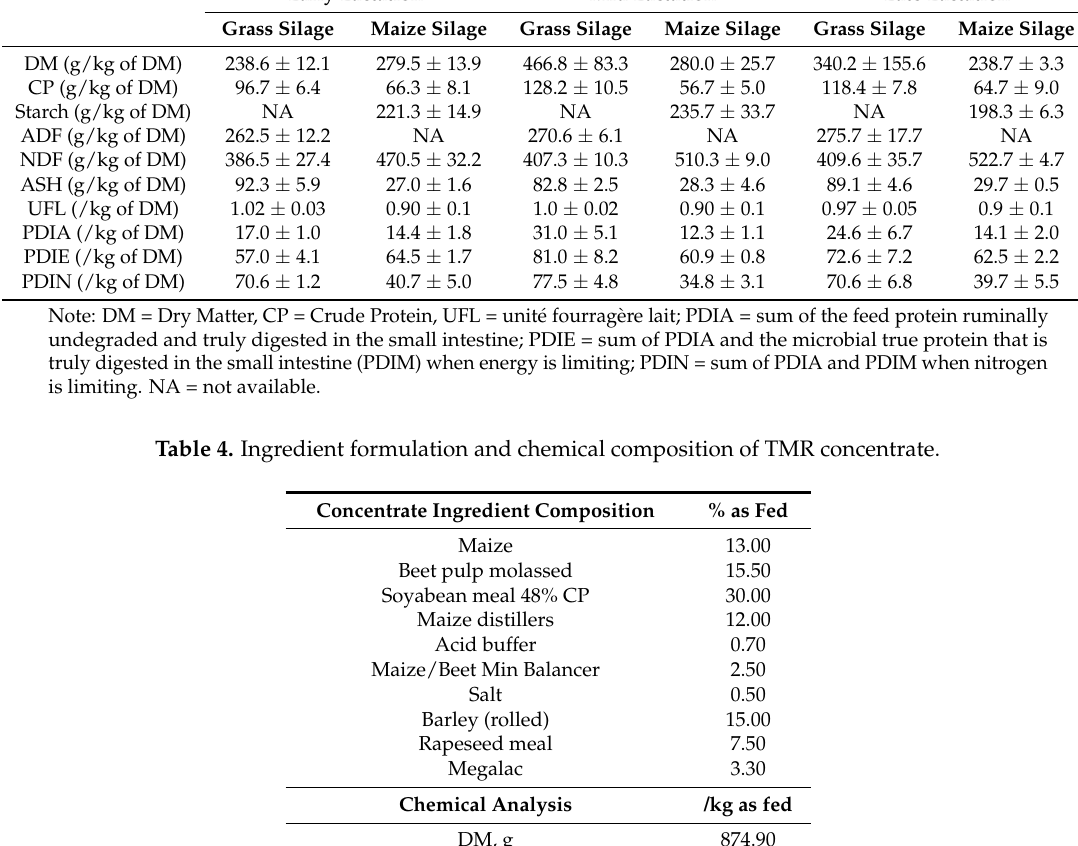
Table 3. Chemical composition (mean ± SD) and nutritional content of silages from TMR diet (grass silage and maize silage) collected weekly throughout lactation analysed by near-infrared spectroscopy. Early Lactation Mid Lactation